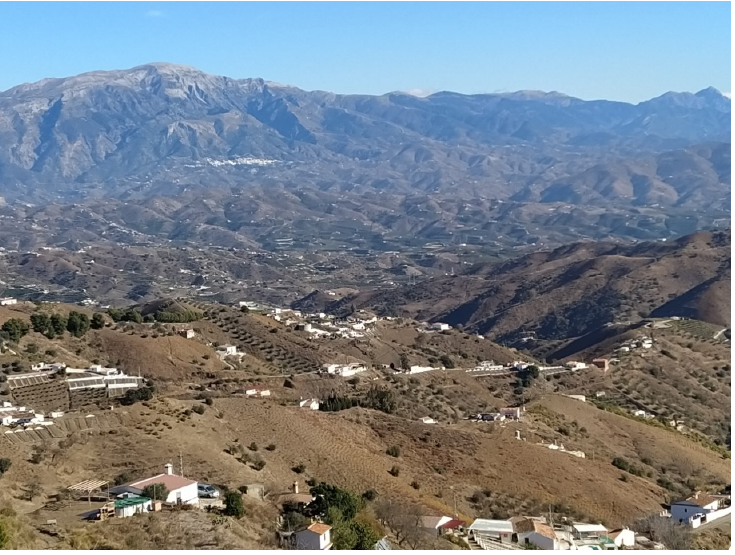
Figure 5. Orography and settlement in Axarquía supramunicipal district. Source: Authors.